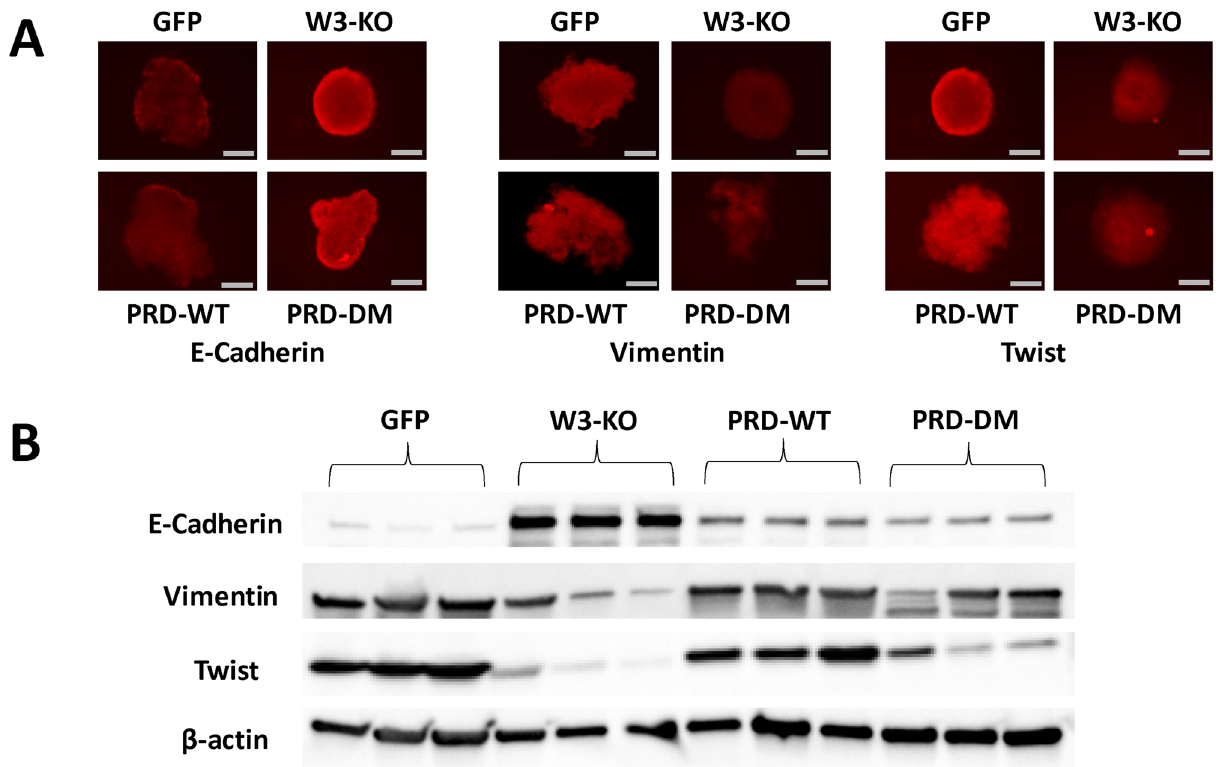
Figure 7. Phosphorylation of the WAVE3 PRD domain is required for the WAVE3-mediated regulation of the EMT-program and for the YB1-mediated regulation of the cancer stem cell niche: Immunofluorescence and Western Blot data. ( A ) Representative micrographs of tumorspheres derived from parental 4T1 and its derivatives and immunostained with antibodies against the indicated proteins. Scale bar: 150 μm. ( B ) Western blots developed with the indicated antibodies of protein lysates from the primary tumors of mice implanted with the indicated MDA-MB-231 cells and their derivatives. β-Actin was used a loading